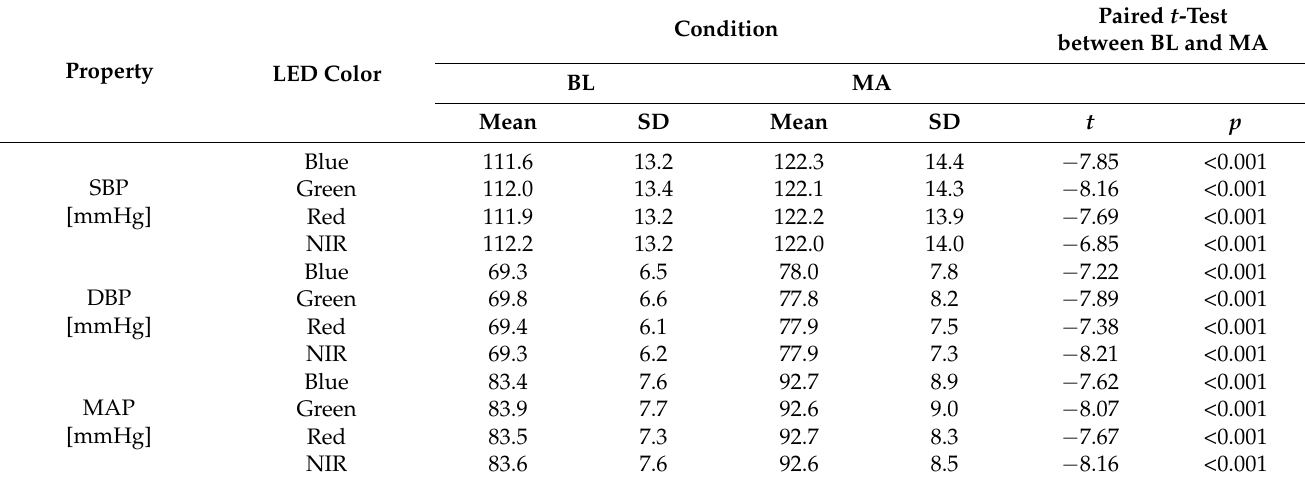
Table 5. Statistical results of estimated BP at 4 wavelengths in each condition.